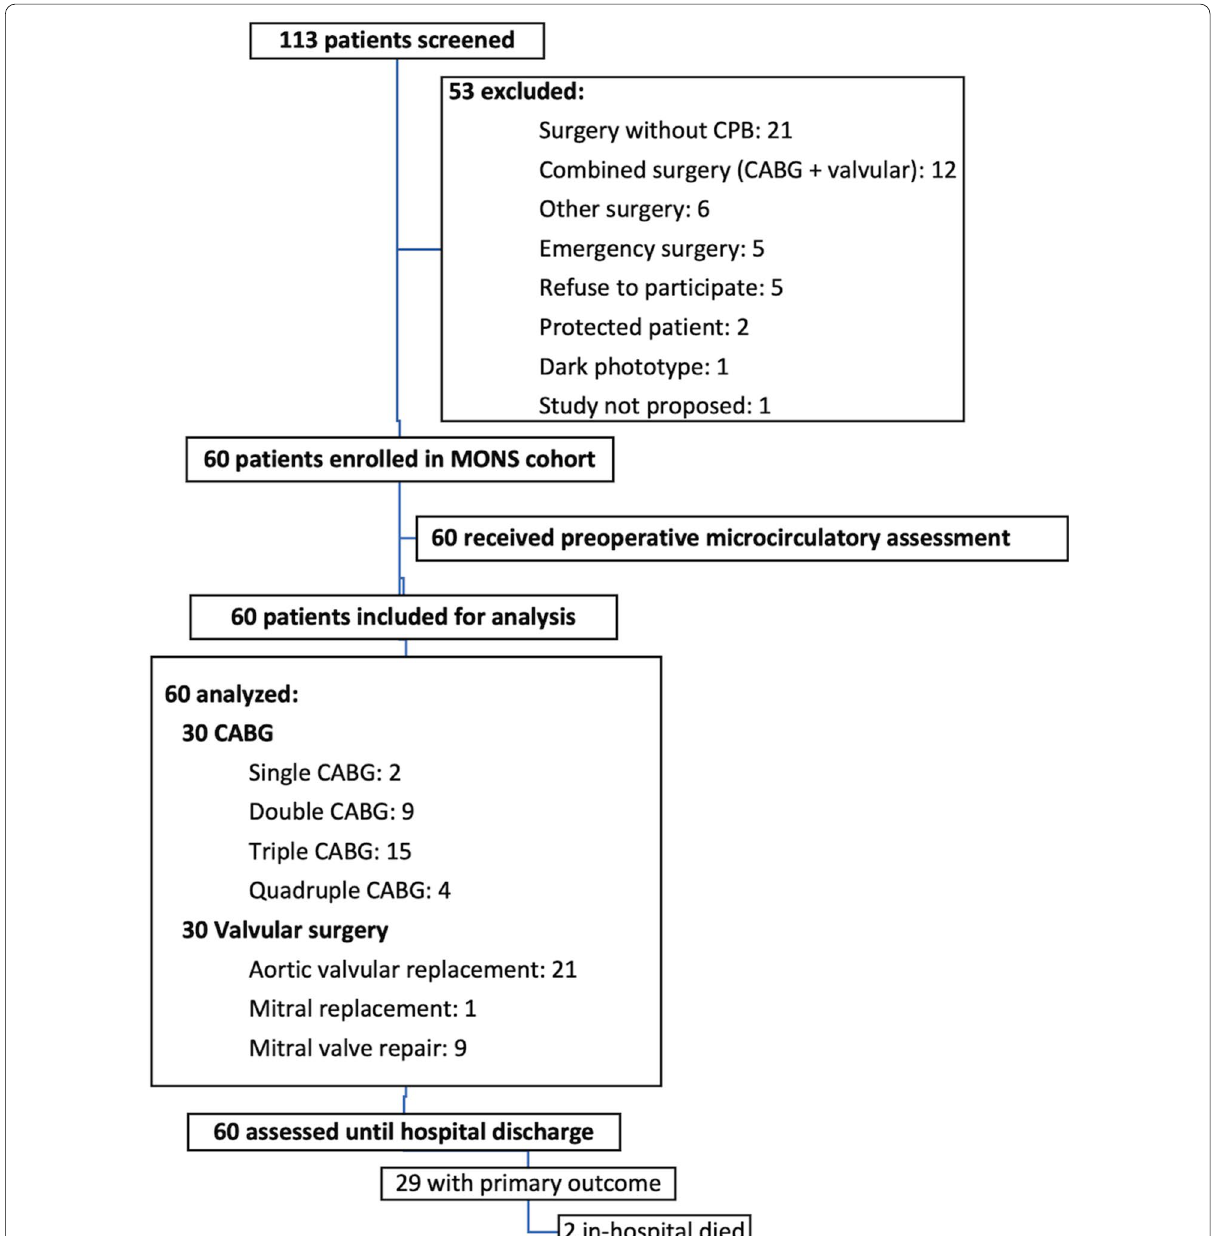
Fig. 2 Study flowchart. CPB cardiopulmonary bypass, CABG coronary arterial bypass